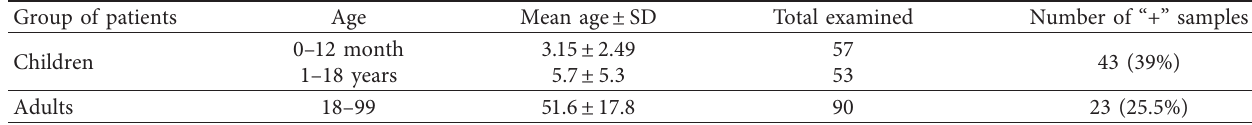
Table 1: Characterization of patients by groups.